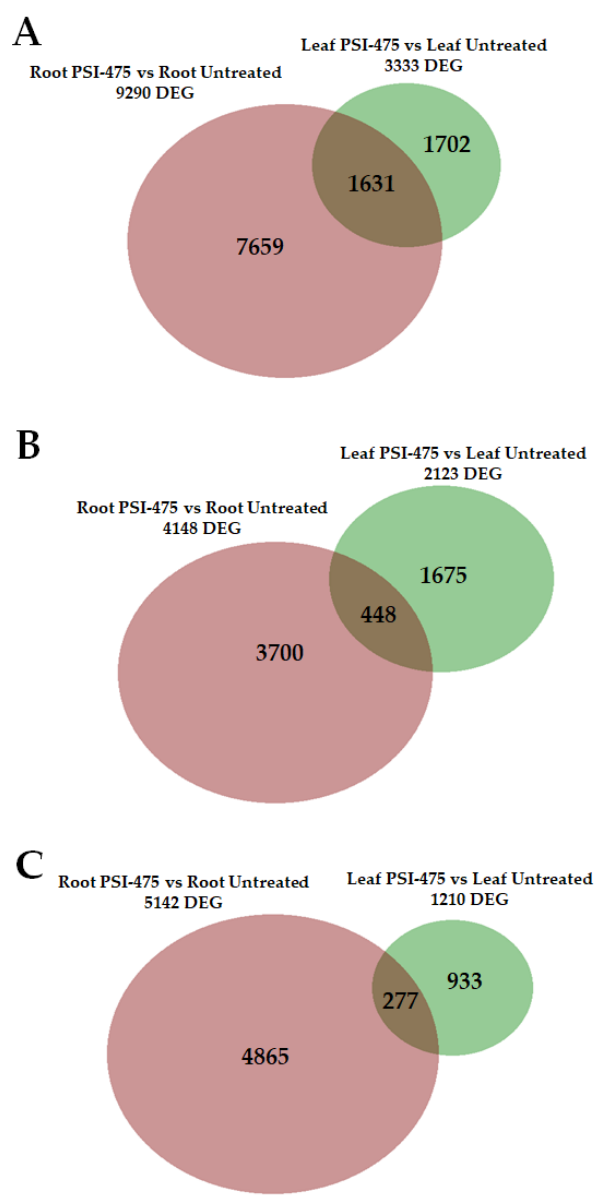
Figure 4. Venn diagram showing the comparison in gene expression of salinity stressed tomato plants treated with PSI-475 in root and young leaf tissue. ( A ) Total DEGs; ( B ) upregulated DEGs; ( C ) downregulated DEGs. Non-overlapping numbers represent the number of genes unique to each tissue. Overlapping numbers represent the number of mutual genes between tissues.